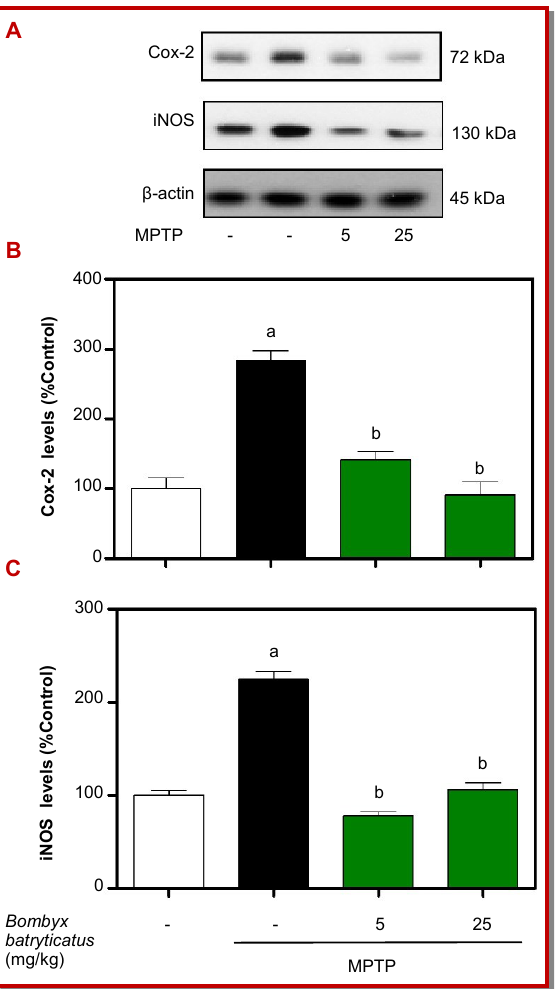
Figure 3: Effect of B. batryticatus on MPTP-induced expression of Cox-2 and iNOS in SNpc of mice brain. (A) Western blot analysis of Cox-2 and iNOS. β -actin is the internal control. Determination of (B) Cox-2 and (C) iNOS levels in the SNpc. Values are presented as mean ± standard error of the mean. a p<0.001 vs. control group; b p<0.001 vs. MPTP-treated group. MPTP, 1-methyl 4-phenyl 1,2,3,6-tetrahydropyridine; SNpc, substantia nigra pars compacta; Cox-2,